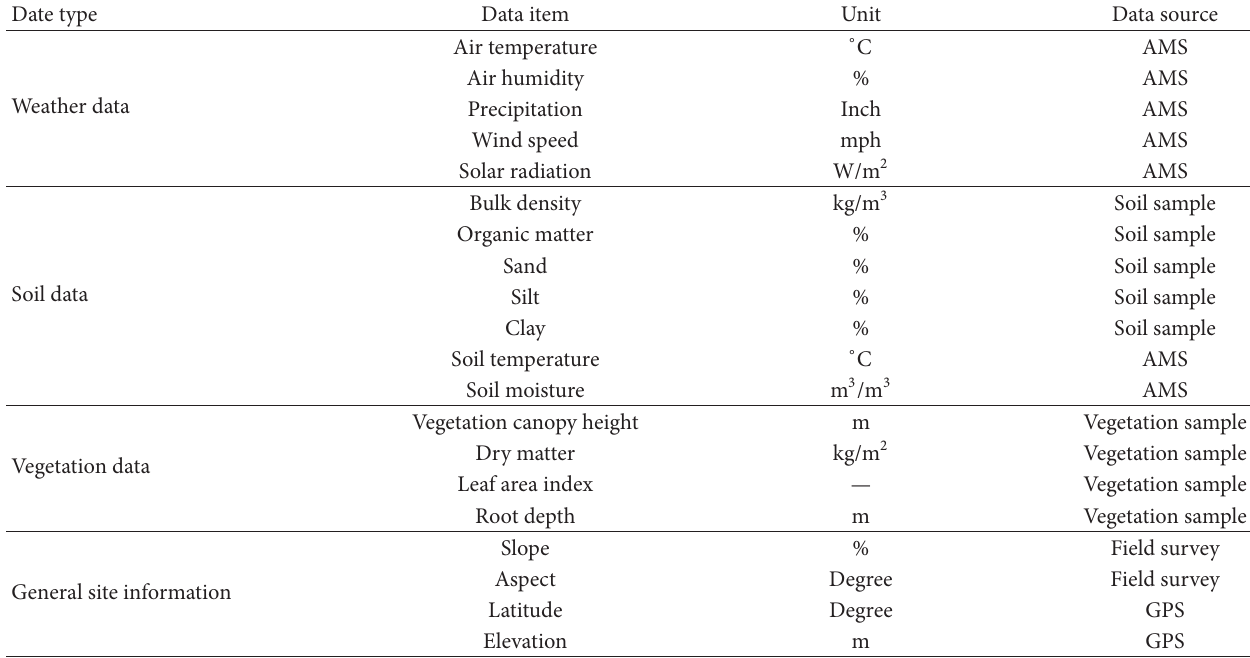
Table 1: Main inputs to the SHAW